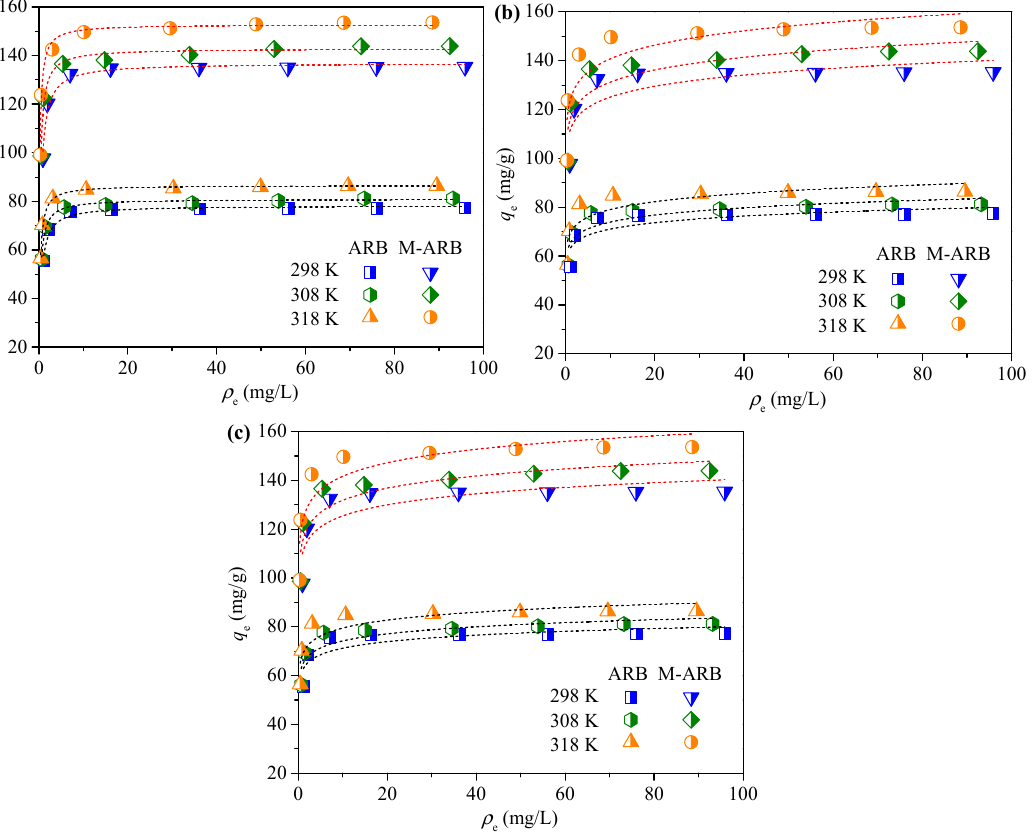
Figure 9. Isothermal adsorption fitting of Langmuir model ( a ), Freundlich model ( b ), and Temkin model ( c ). Table 4. Isothermal adsorption fitting parameters of MB onto ARB and M-ARB.